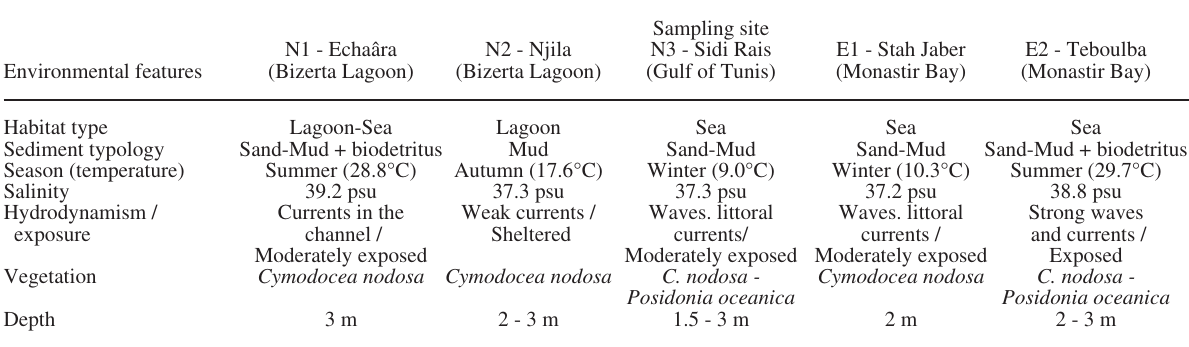
Table 1. – environmental characteristics assessed during the sampling period for the five